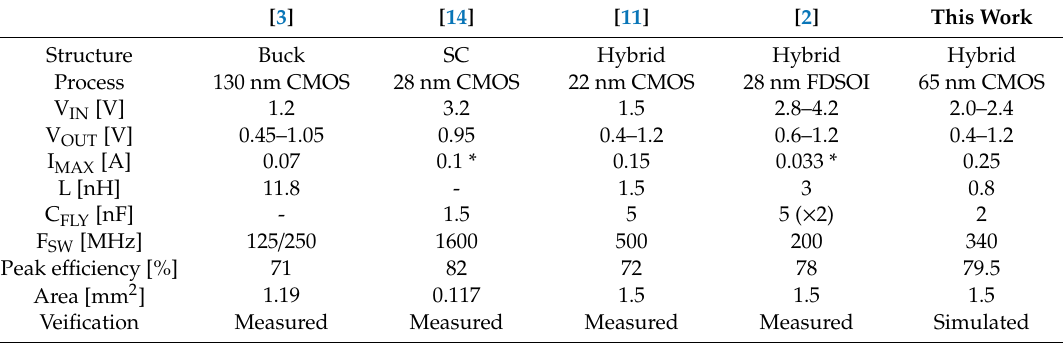
Table 1. Performance comparison of di ff erent FIVRs (fully integrated voltage